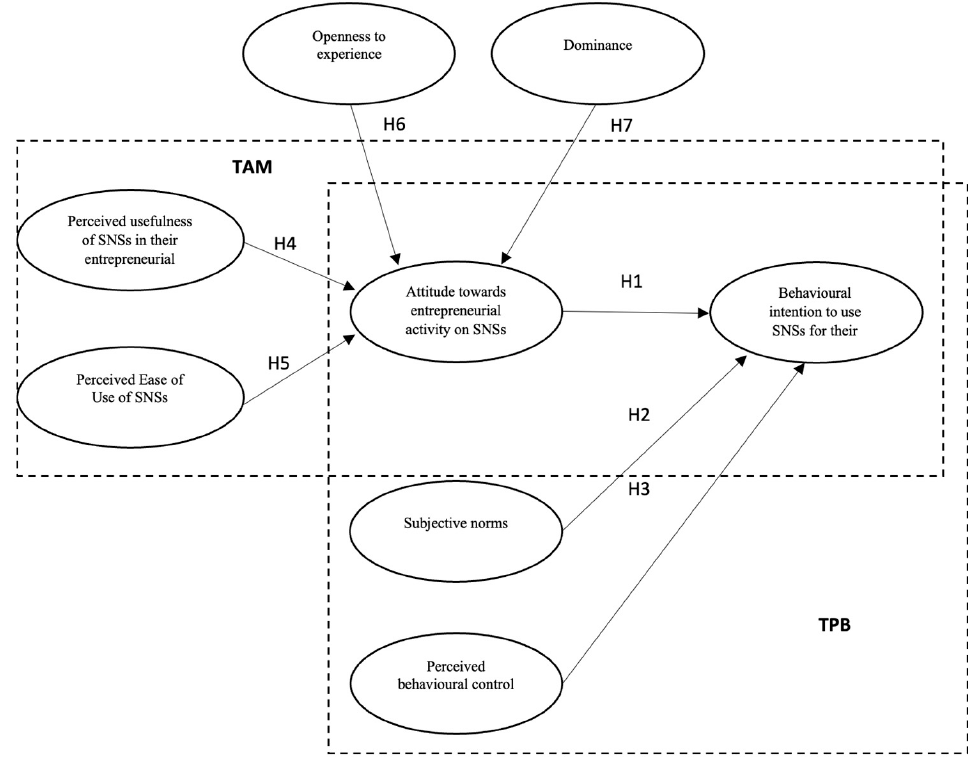
Figure 1. The research model.